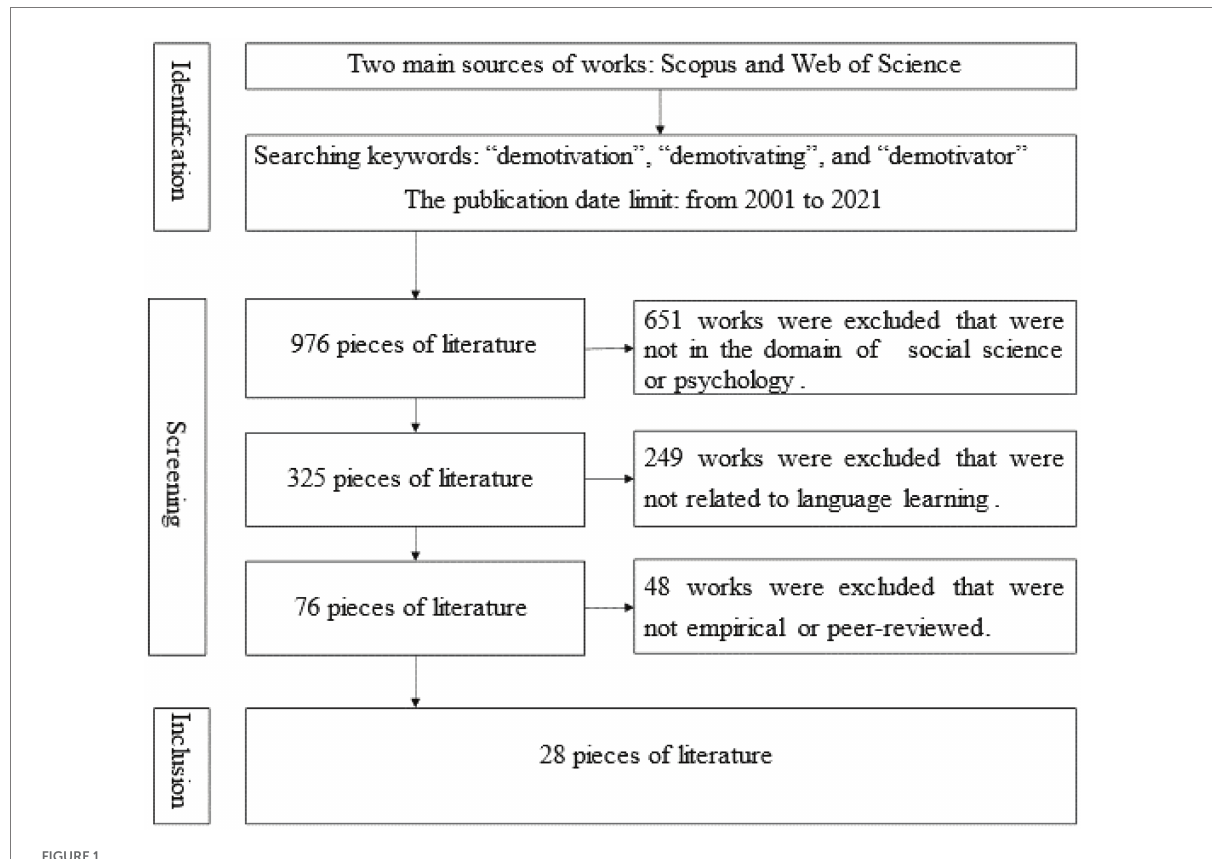
FIGURE 1 Process of literature